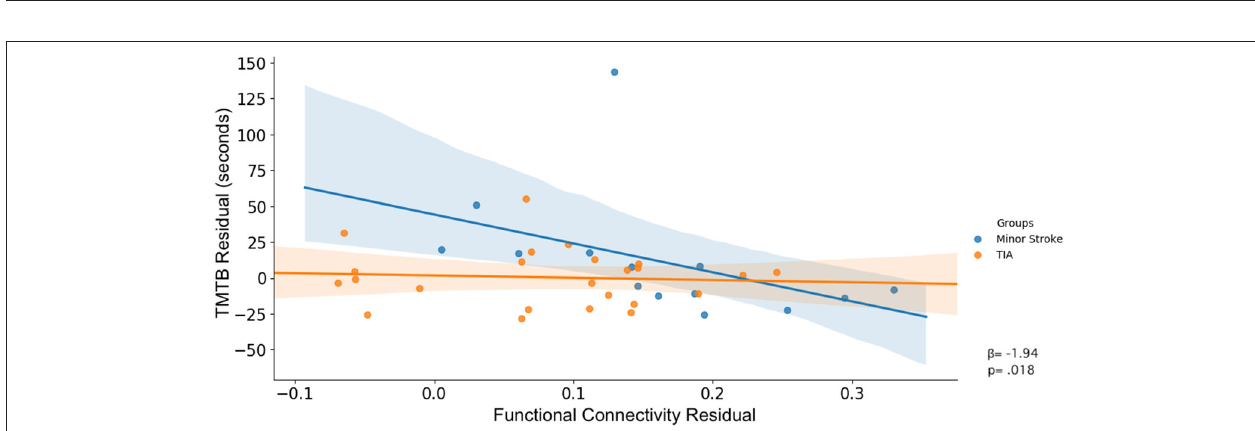
FIGURE 3 | Uncorrected interaction of functional connectivity between two nodes (X-axis), cognitive performance (Y-axis) and group (legend). Shaded areas indicated the 95%-confidence intervals around the correlation coefficients. (A) FPN ⇔ FPN, (B) FPN ⇔ DMN, (C) FPN ⇔ FPN, (D) FPN ⇔ FPN.